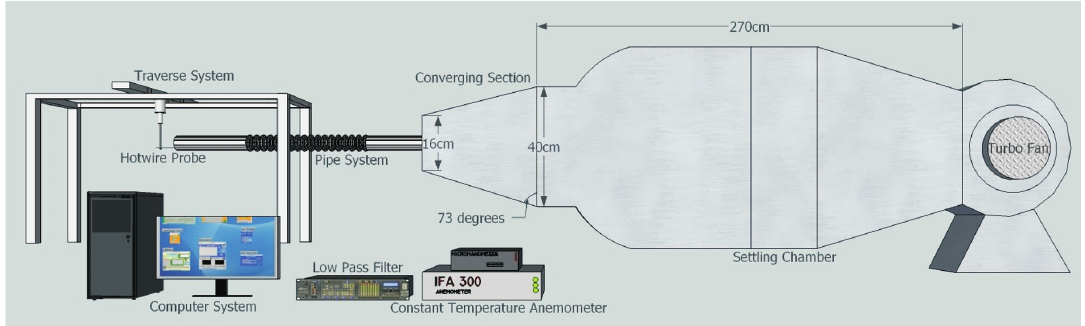
Figure 4. 3D sketch of experimental set-up and pipe